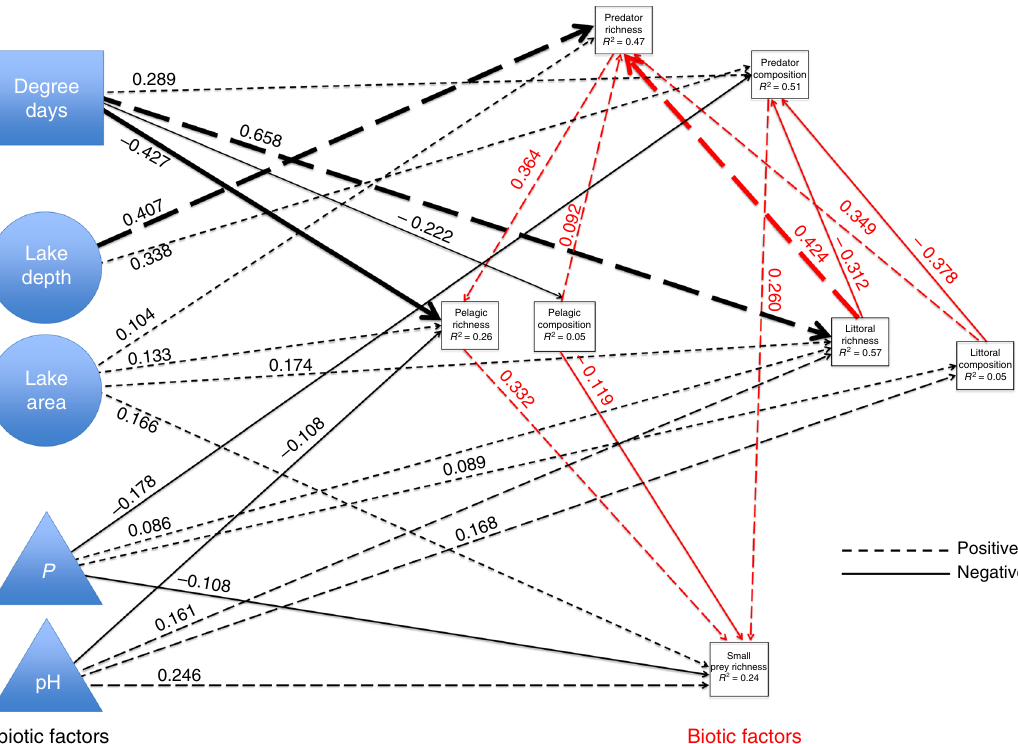
Fig. 1 Direct and indirect drivers of species richness in fi sh. SEM-derived multivariate relationships among integrated abiotic and biotic regulatory factors (blocks = degree days, circles = lake morphometry, triangles = water quality, and biotic factors [red lines]) for the richness and composition of four major fi sh functional groups in 721 lakes along an 11° latitudinal gradient in Ontario, Canada SEM integrative model:, n = 648, ML 13, P = 0.977, see Methods and Supplementary Note 1). Solid lines indicate negative relationships; dashed lines indicate positive relationships. Arrows indicate the direction of the relationship. Bold lines indicate stronger relationships, arbitrarily assigned as standardized path coef fi cient values > 0.40. Black lines indicate abiotic in fl uences on biotic factors and red lines indicate in fl uences between biotic factors. Functional groups are predator, littoral, pelagic, and small-prey species, with full species list given in Supplementary Table